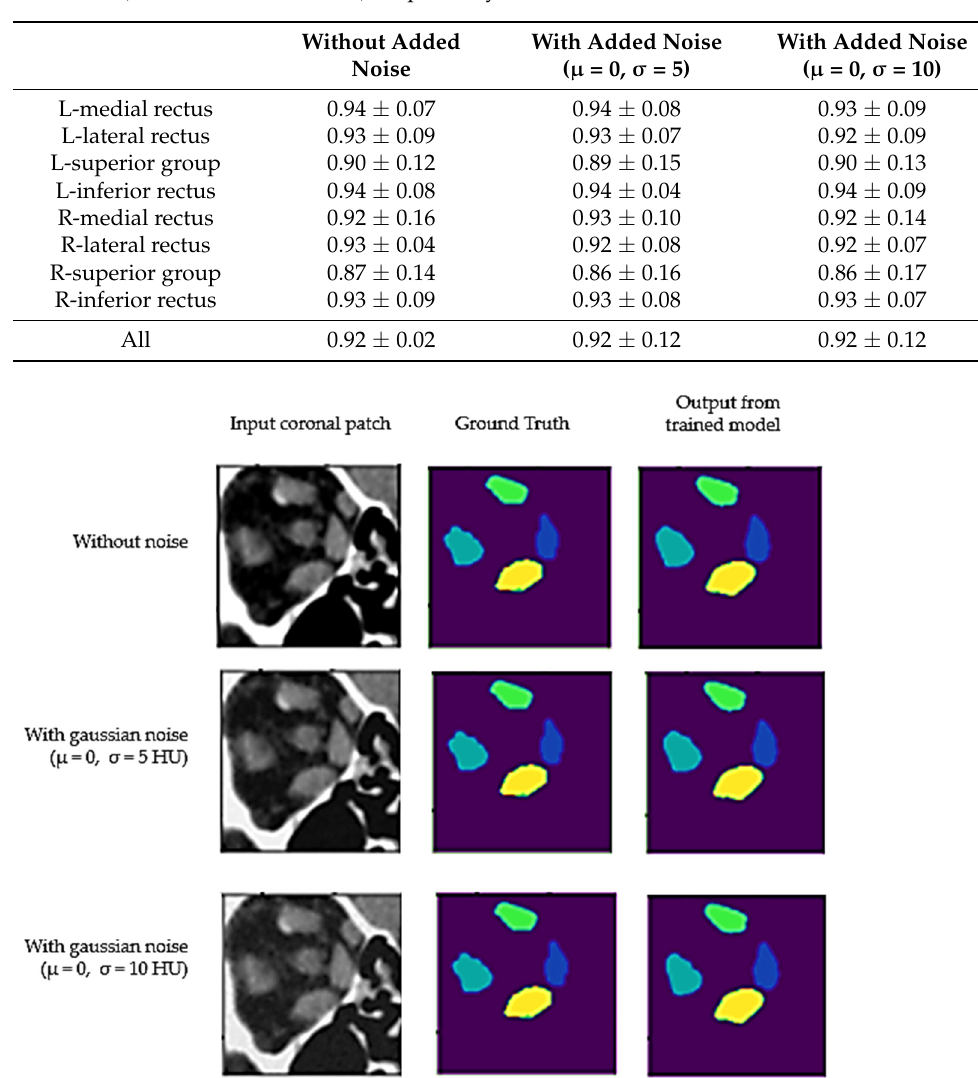
Table 6. Average performance of the trained U-net on 32 test cases where input images were added with different levels of Gaussian noise. Values indicate mean DSC (and standard deviation) and mean IOU (and standard deviation), respectively.